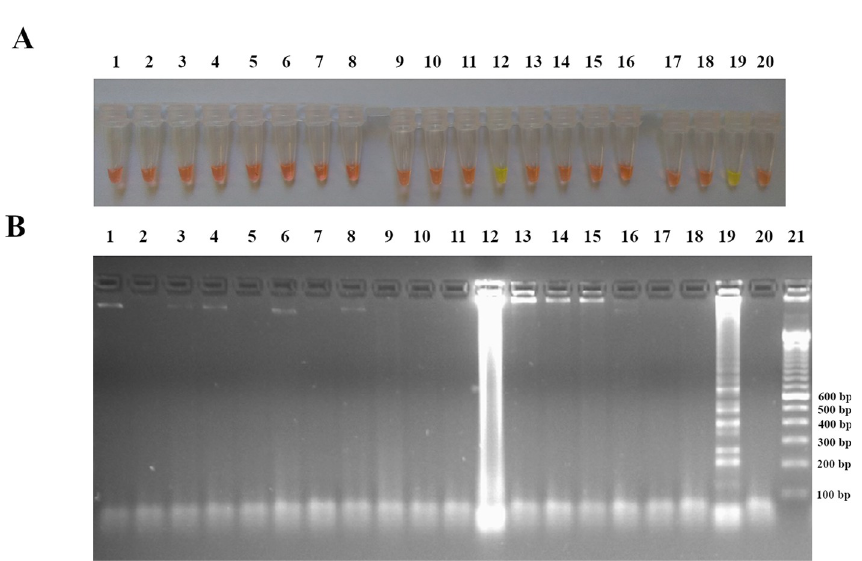
Fig 5. Cross-reactions of LAMP caf1 . LAMP reaction was assessed for DNA amplification of 14 pathogens: (A) Eye visualization of LAMP reaction after SYBR Green I addition, (B) visualization after gel electrophoresis migration of the LAMP products. Tubes and Lanes 1: Y . enterocolitica , 2: extraction control, 3: Y . pseudotuberculosis , 4: E . cloacae , 5: E . coli , 6: S . sonnei , 7: P . mirabilis , 8: S . odorifera , 9: S . marcescens , 10: P . aeruginosa , 11: S . aureus , 12: M . tuberculosis (1), 13: M . tuberculosis (2), 14: M . tuberculosis (3), 15: M . tuberculosis (4), 16: P . vivax , 17: P . falciparum , 18: T . solium ,19: Y . pestis , 20: no DNA template (sterile distilled water) and Lane 21: DNA ladder marker 100 bp.